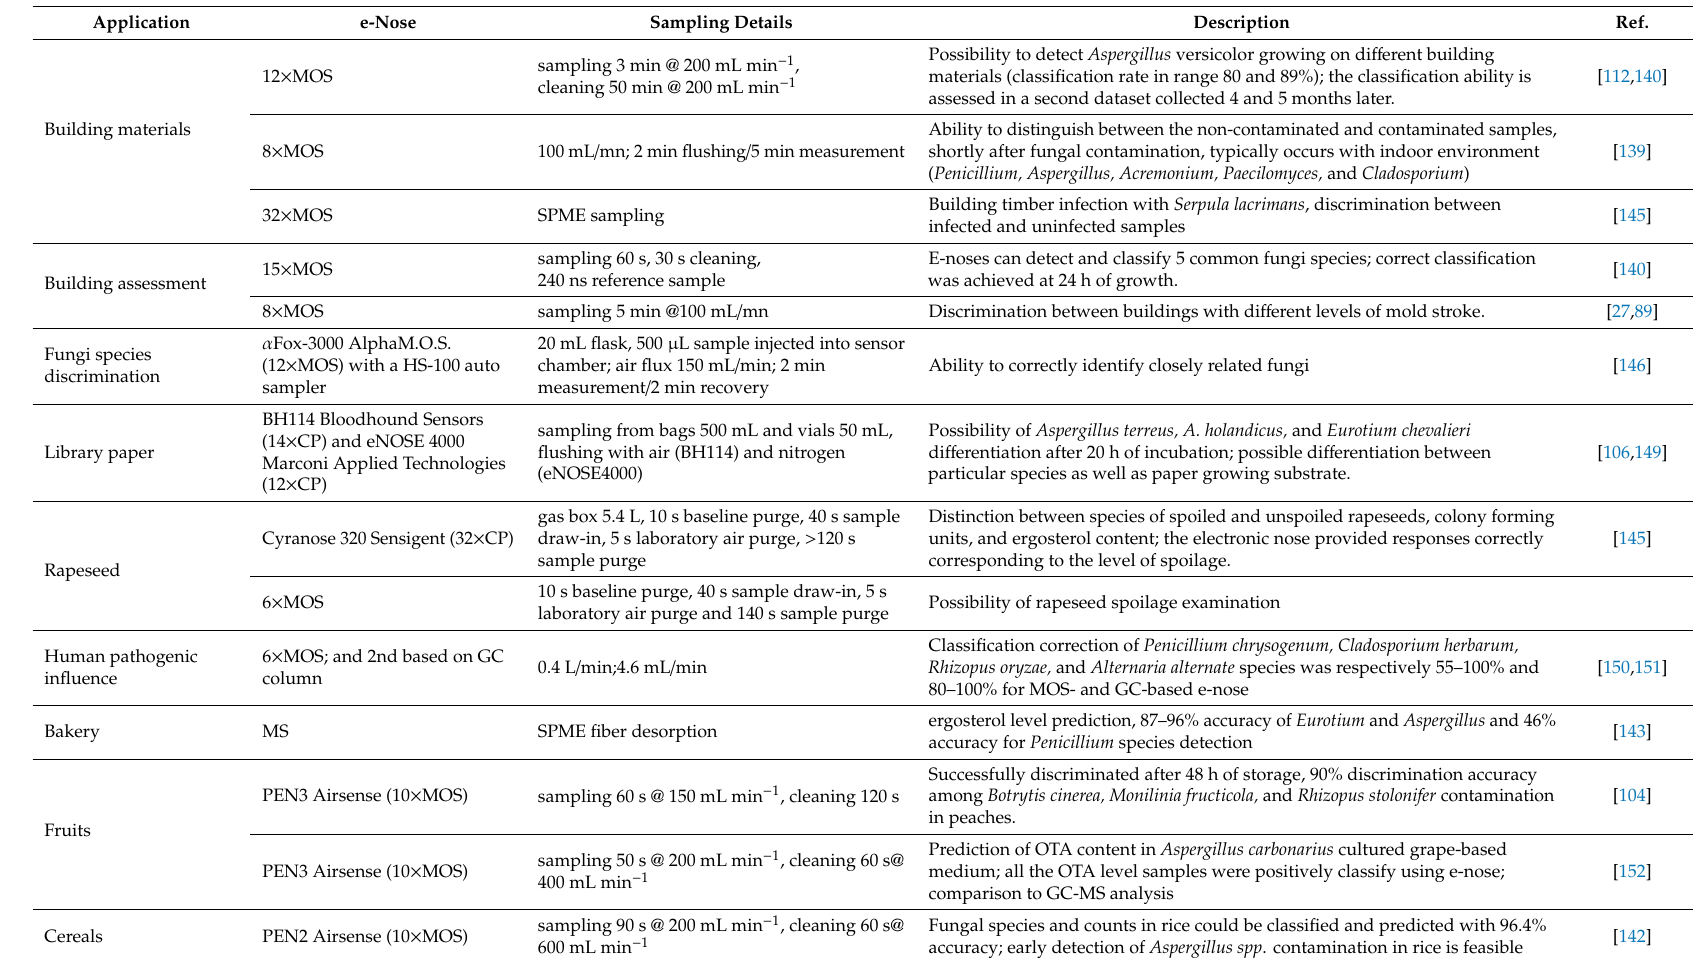
Table 3. Chosen application of e-nose for fungal contamination assessment 1